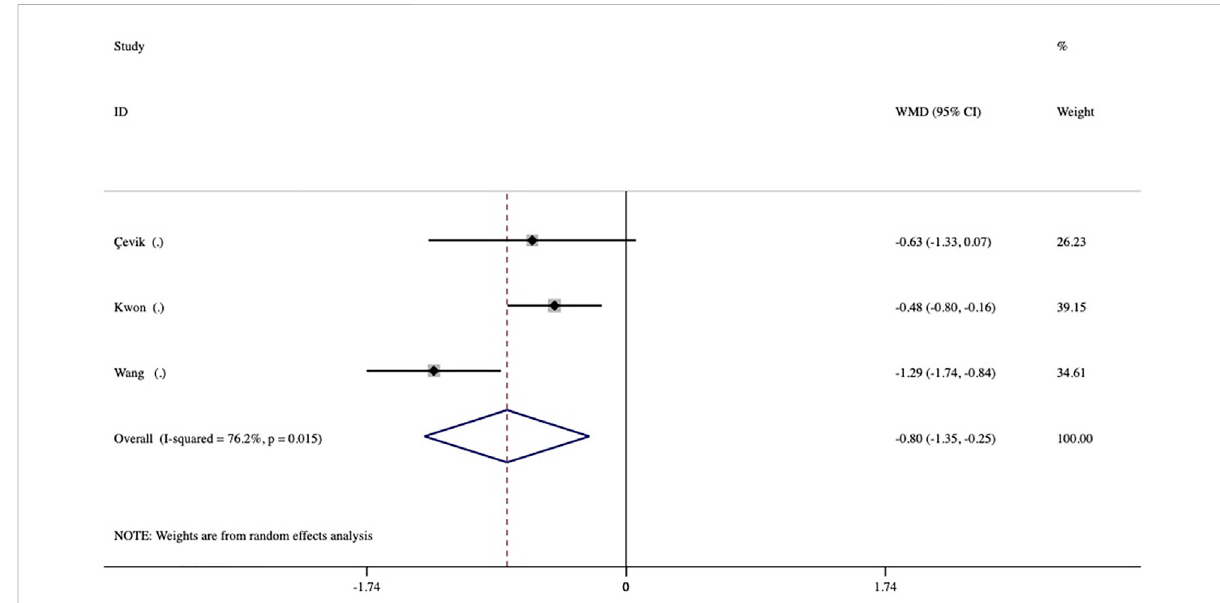
Forest plots of the comparison of the mean duration of action (intervals of macular edema recurrence) between the vitrectomized and nonvitrectomized groups.